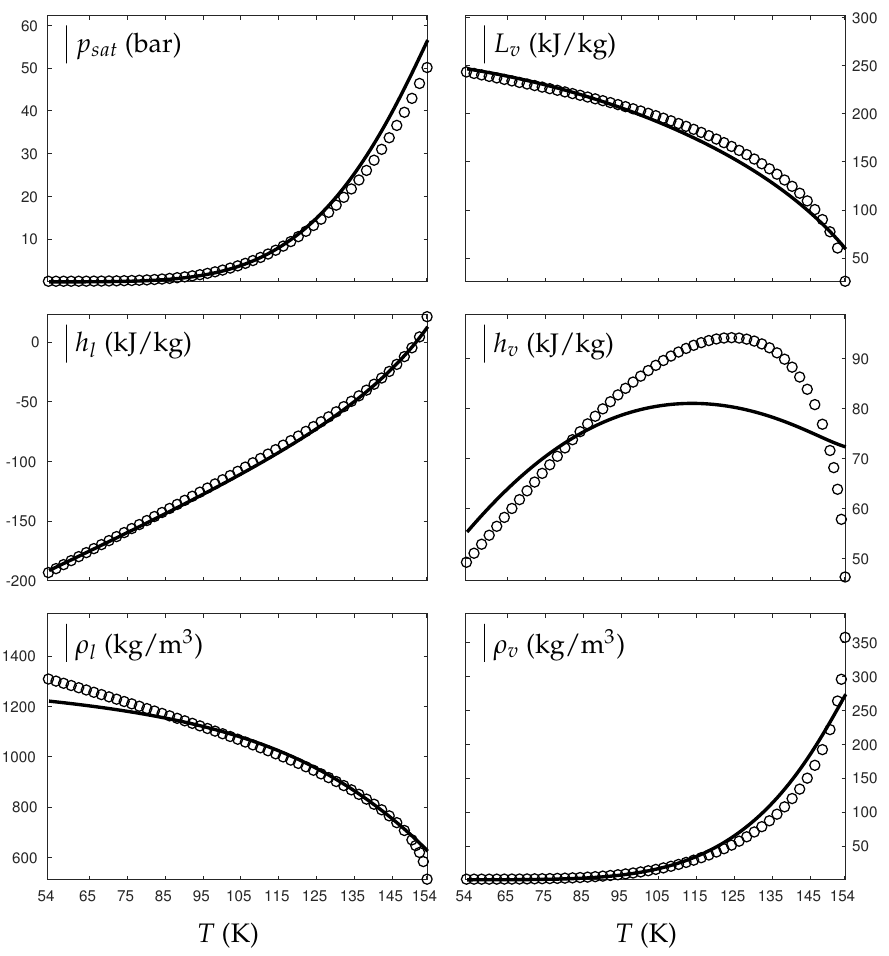
Figure A2. Comparison between experimental and theoretical saturation curves for liquid l and vapor v oxygen. Symbols represent experimental data. The thick lines represent the theoretical saturation curves obtained with the liquid Extended NASG EOS (ENASG) Equation (56) and its “alternative” but conditionally convex formulation for the vapor phase, Equation (A38). p sat denotes the saturation pressure, L v the latent heat, h the specific enthalpy and ρ the density.